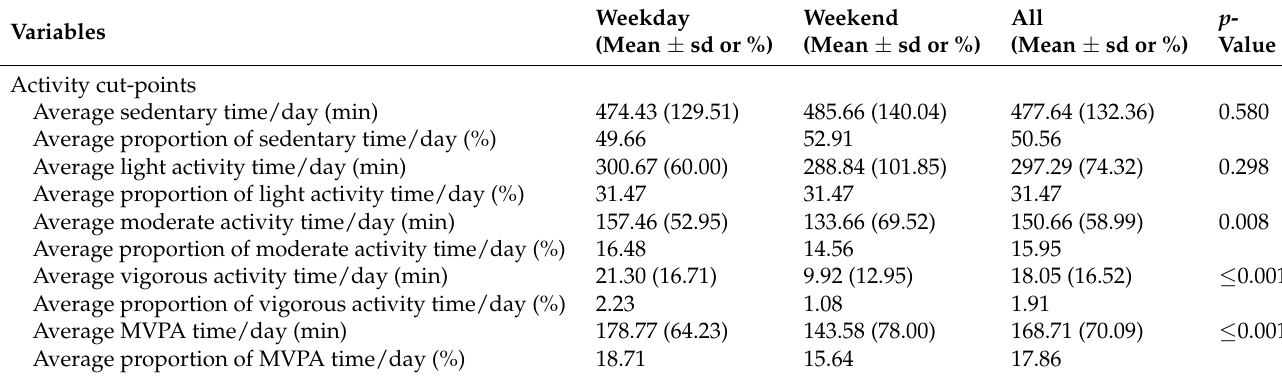
Table 3. Descriptive statistics of physical activity (n = 31).